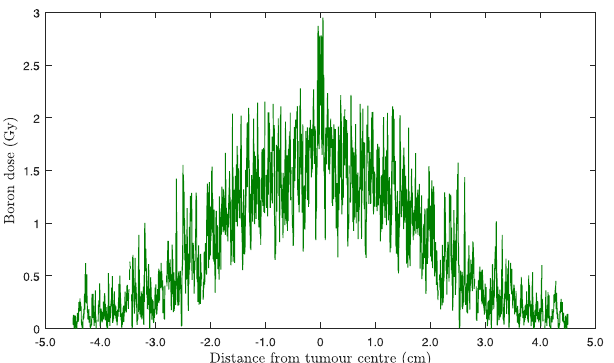
Figure 3. Transverse profile of the calculated cell-based boron dose distribution (combined 7 Li and alpha dose matrices) in the scoring plane versus distance from the tumour centre. The statistical uncertainty of the calculated results (the relative error between several runs) was ∼±